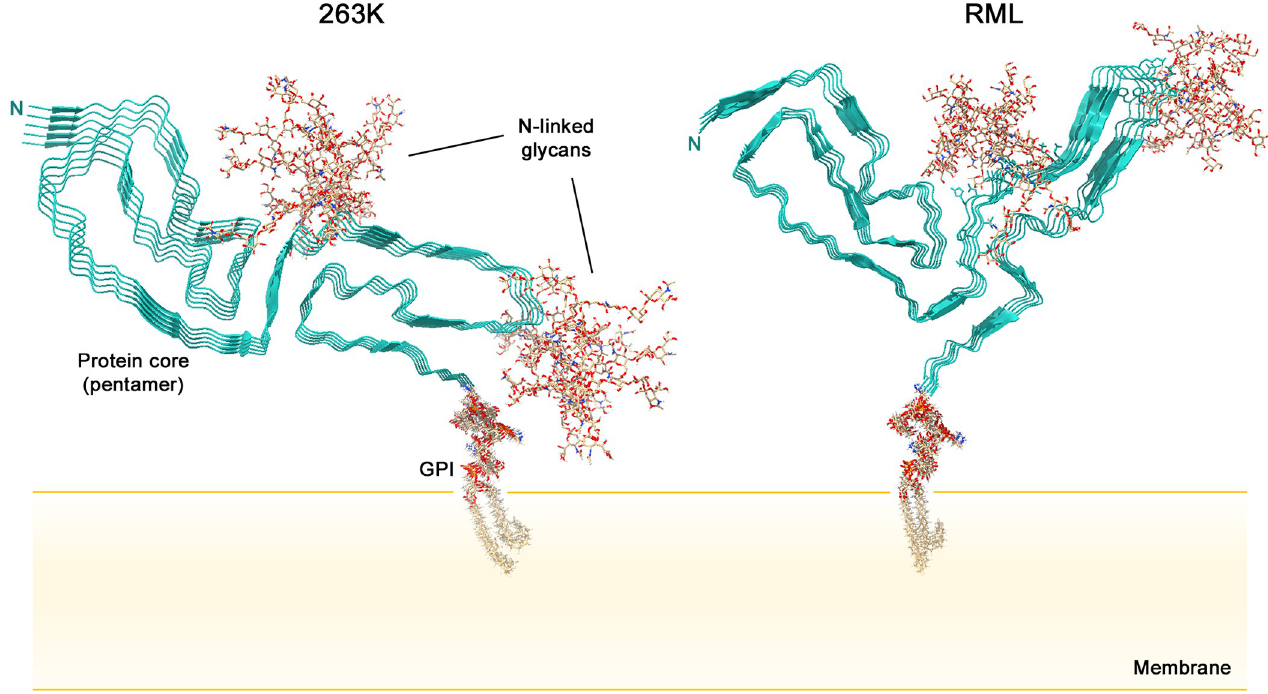
Fig 2. Cross-sectional depictions of membrane-bound 263K and RML prions. For simplicity, only short pentameric segments of the fibrils are shown. The natural glycans and GPI moieties are much more heterogeneous than those shown. The RML structure shown was assembled using the aRML pdb coordinates (PDB: 7TD6) because the wtRML pdb coordinates were not yet publically available. Although the aRML and wtRML cores are similar overall, there are detailed features of the wtRML core structure that differ from that depicted. See [10]. GPI, glycophosphatidylinositol.